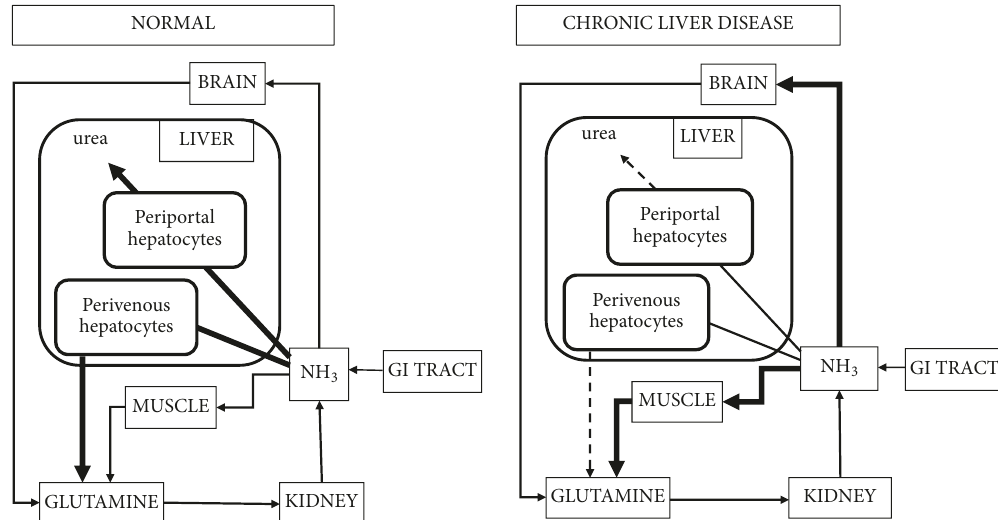
Figure 1: Classical viewof interorgantraffickingof ammonia (derived principally from proteindigestion in thegastrointestinaltract)between liver, muscle, and brain under normal physiological conditions compared to chronic liver disease. Note the decrease of ammonia removal as urea and glutamine by periportal and perivenous hepatocytes, respectively, in chronic liver disease accompanied by increased removal of ammonia by skeletal muscle and increased uptake of ammonia by brain, a key factor in the pathogenesis of